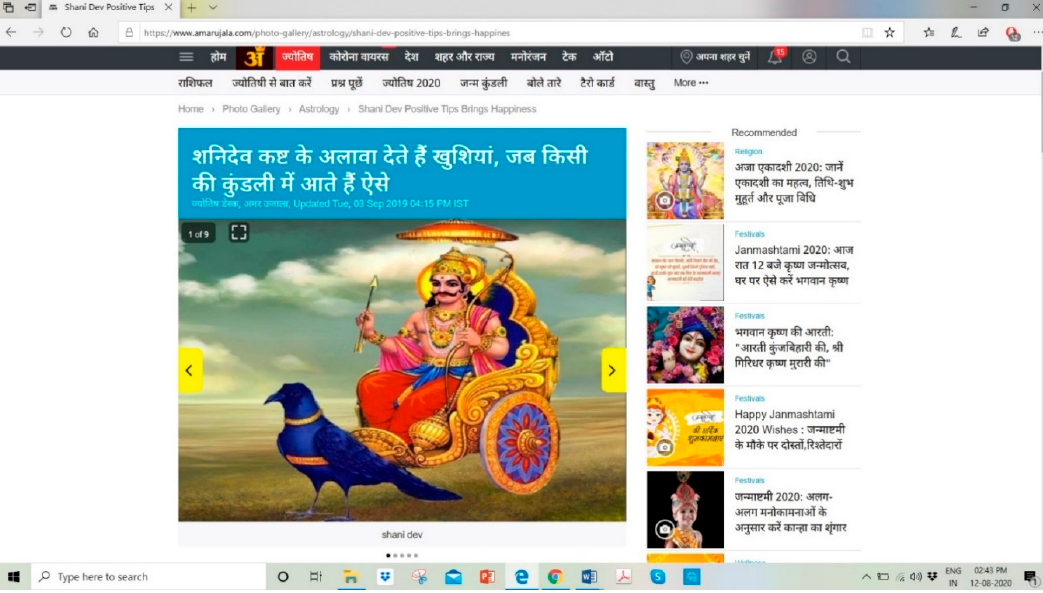
Figure 4. Shani riding a golden chariot. Source: AmarUjala.